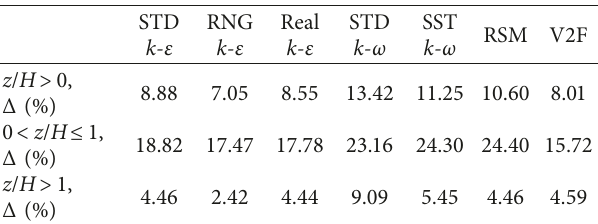
ref passing through the center of the canyon Table 3: Percentage differences between measured and modeled velocities within and above the canyon (AR 1). (cid:31)